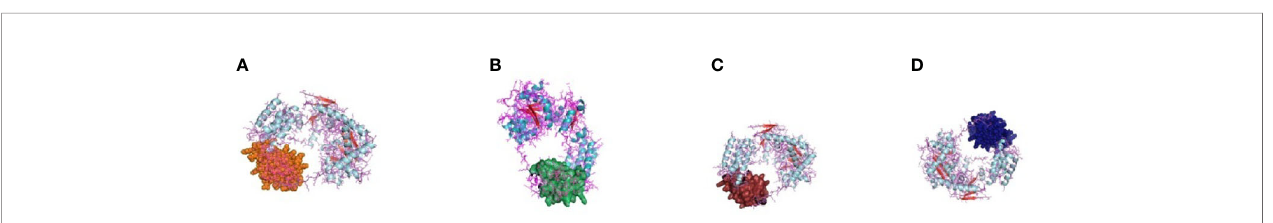
FIGURE 2 | (A) RLR_C-terminal domain of the gene of sheep. (B) RLR_C_like domain of RIG gene of sheep. (C) LGP2_C, C-terminal domain of Laboratory of Genetics and Physiology 2 (LGP2) of sheep. (D) MDA5_C, C-terminal domain of melanoma differentiation-associated protein 5 of sheep.